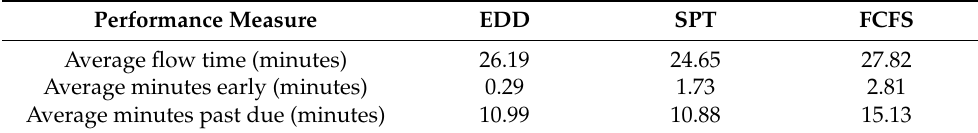
Table 8. The effect of change in length of conveyor belt on performance measures. Performance